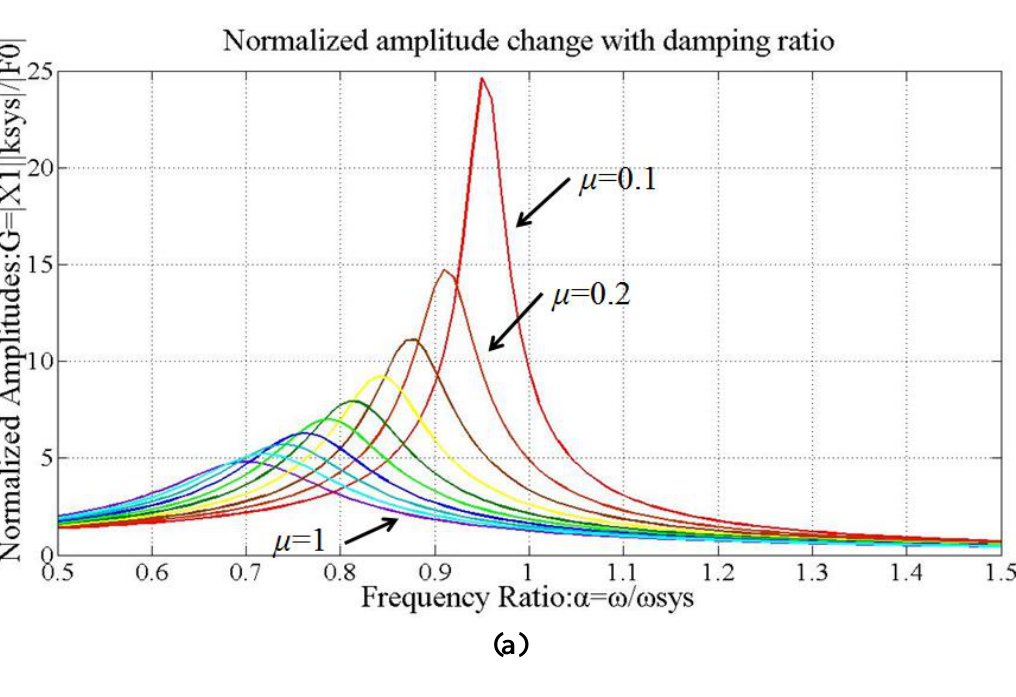
Figure 12. Normalized amplitudes of vibrations: (a) ζ (fixed), ζ = abs